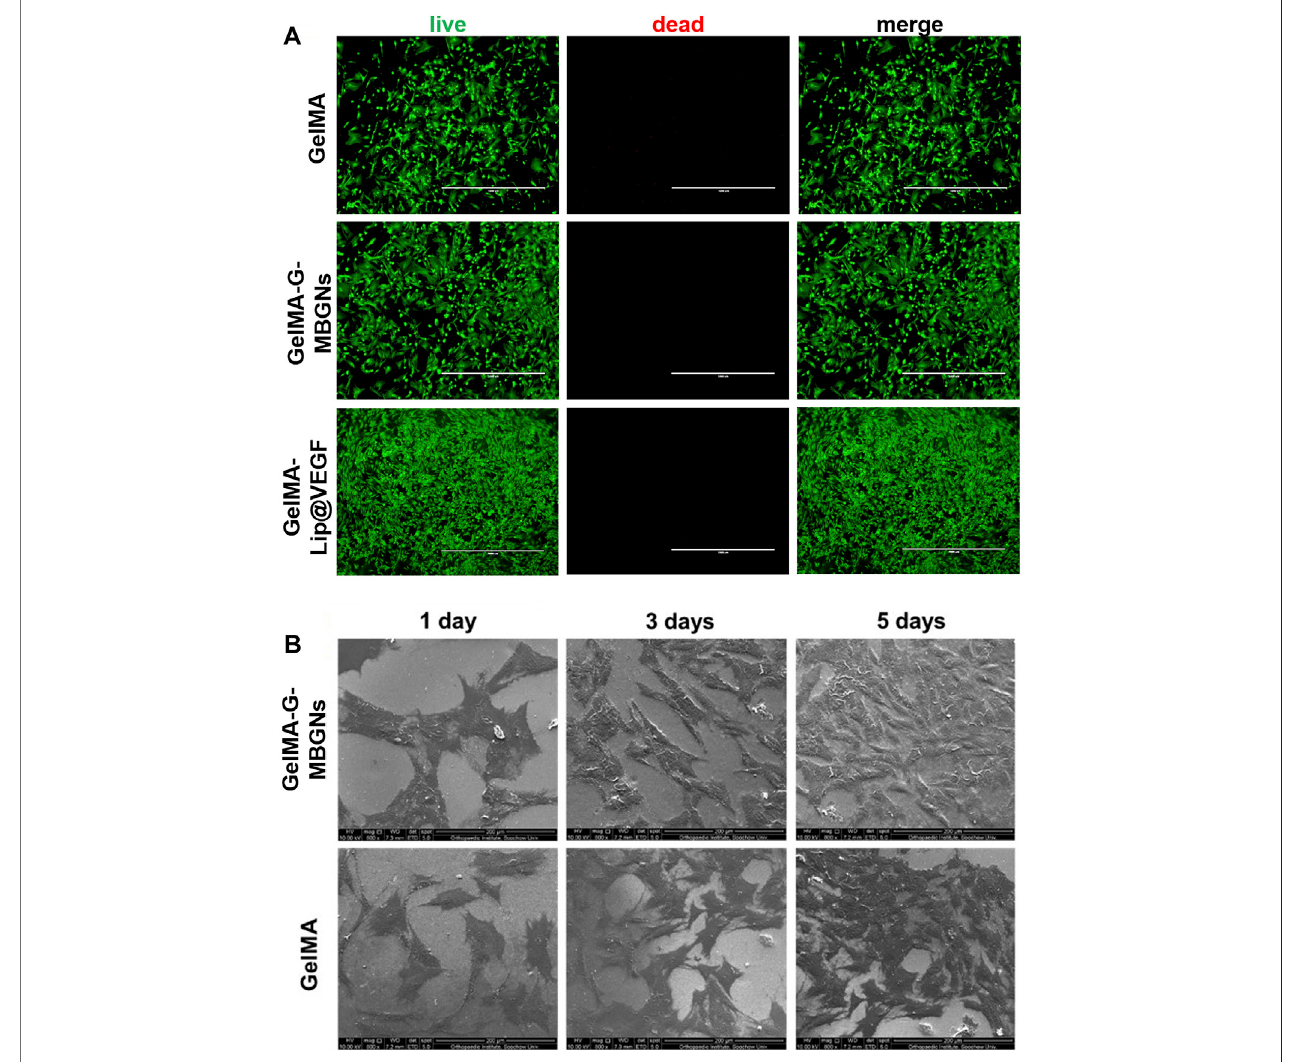
FIGURE 5 | Characterization of biocompatibility. (A) Live/Dead staining of BMSCs seeded on hydrogels. (B) SEM observation of BMSCs on hydrogels.